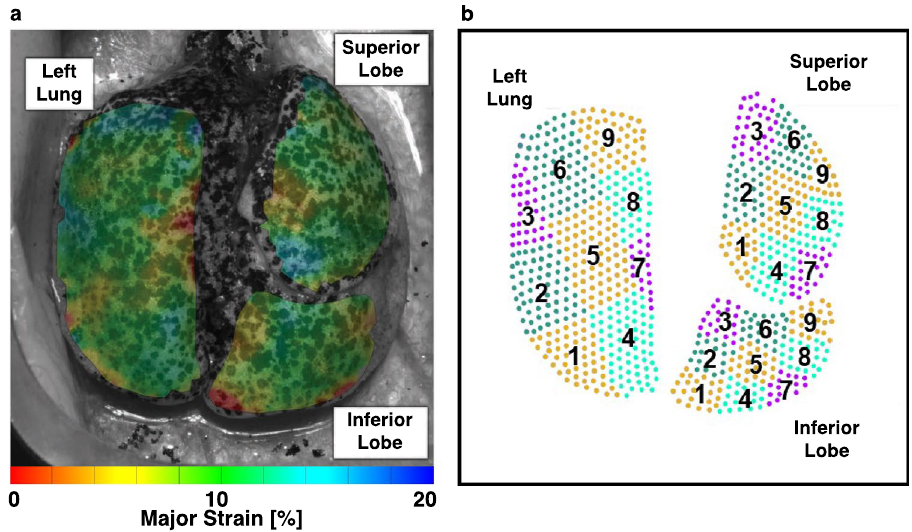
Figure 4. ( a ) Representative murine lung’s major strain contour map. Clockwise from top left, the left lung (LL), superior lobe (SL), and inferior lobe (IL) are labeled. ( b ) Each lobe’s corresponding regions of interest was illustrated and used to compare diseased and healthy specimens’ regional